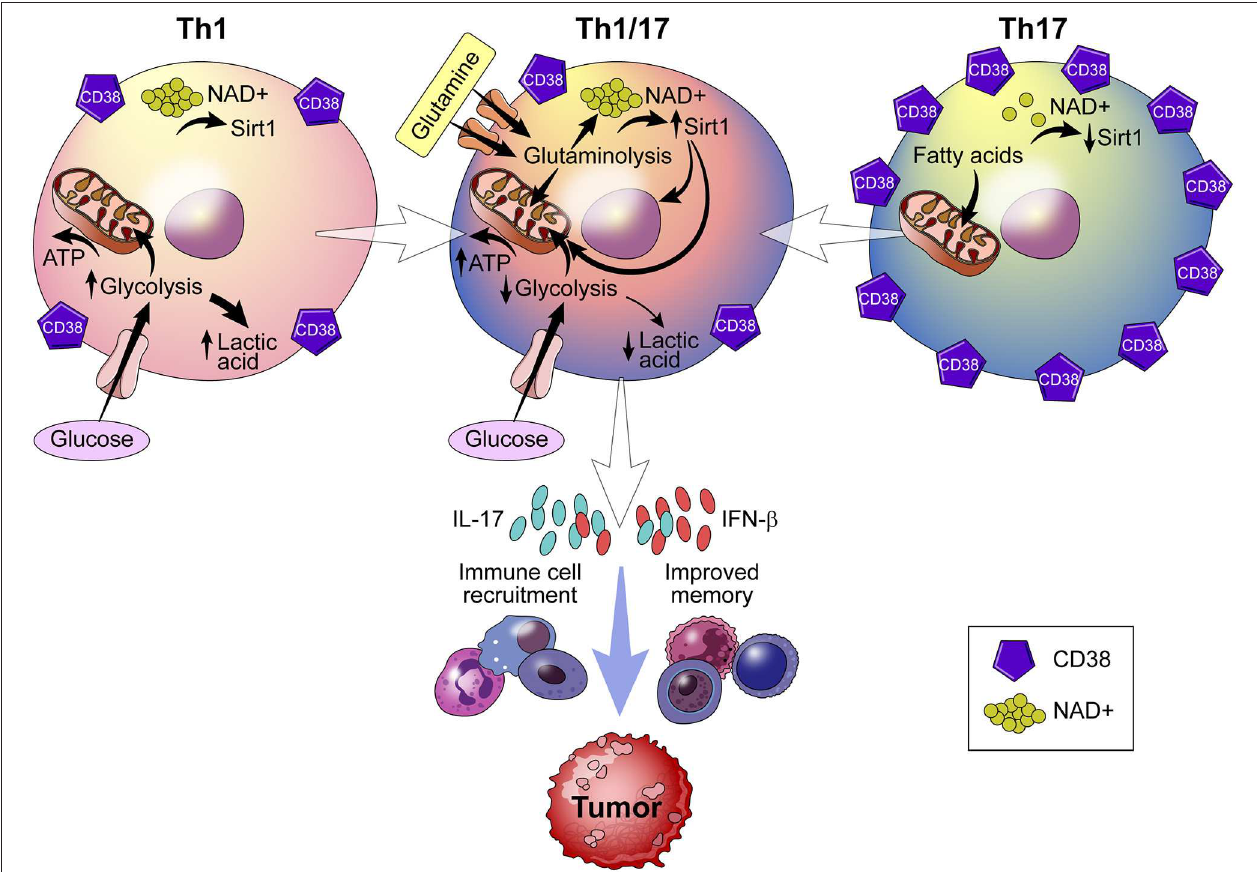
FIGURE 6 | Role of CD38 in immunometabolism and tumor biology . Using a strategy that merges Th1 and Th17 cells into a hybrid Th1/Th17 cell, the CD38-NAD + axis undergoes metabolic reprogramming. Reprogramming results in a shift toward glutamine-driven oxidative phosphorylation, which improves T cell survival, immune cell recruitment to the tumor, and T cell memory. Th1/Th17 hybrid cells also demonstrate reduced expression of CD38 and higher levels of NAD + , which serves as a substrate for NAD + -dependent Sirt1 deacetylase activity that is essential to the T cell response.